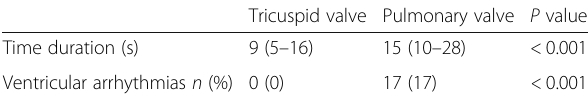
Table 2 Time required to advance the pulmonary artery catheter through the tricuspid and pulmonary valves